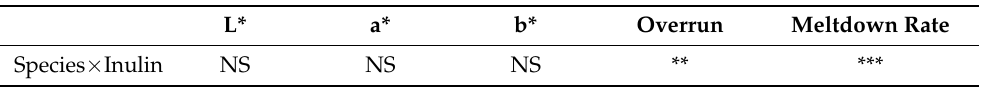
Table 6. Interactions between species and inulin addition observed in color parameters (L*, a*, b*), overrun and meltdown rate of frozen